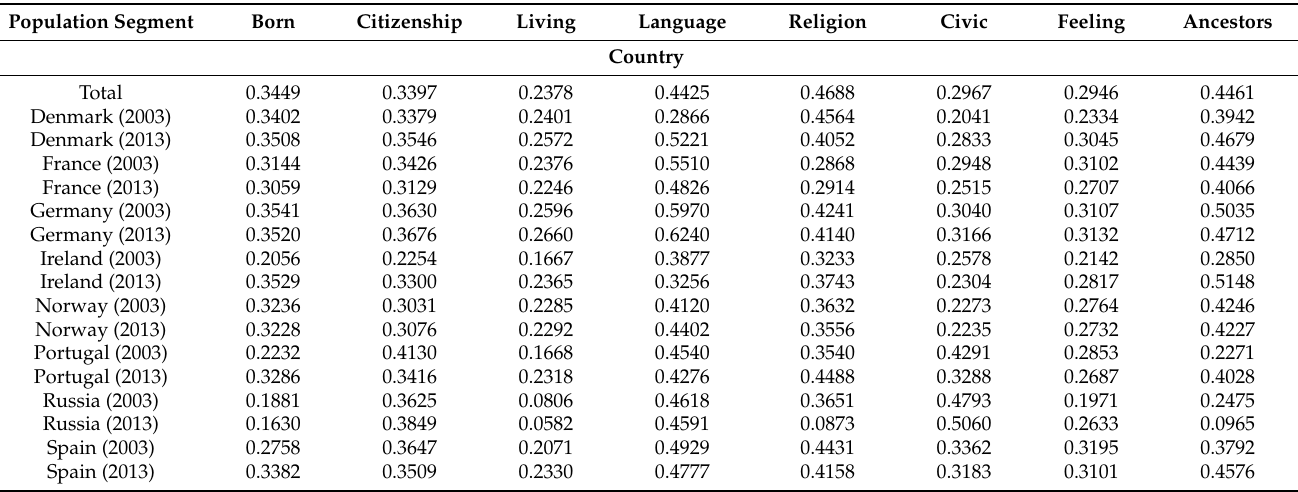
Table 5. Elasticities of RNISI by country and political